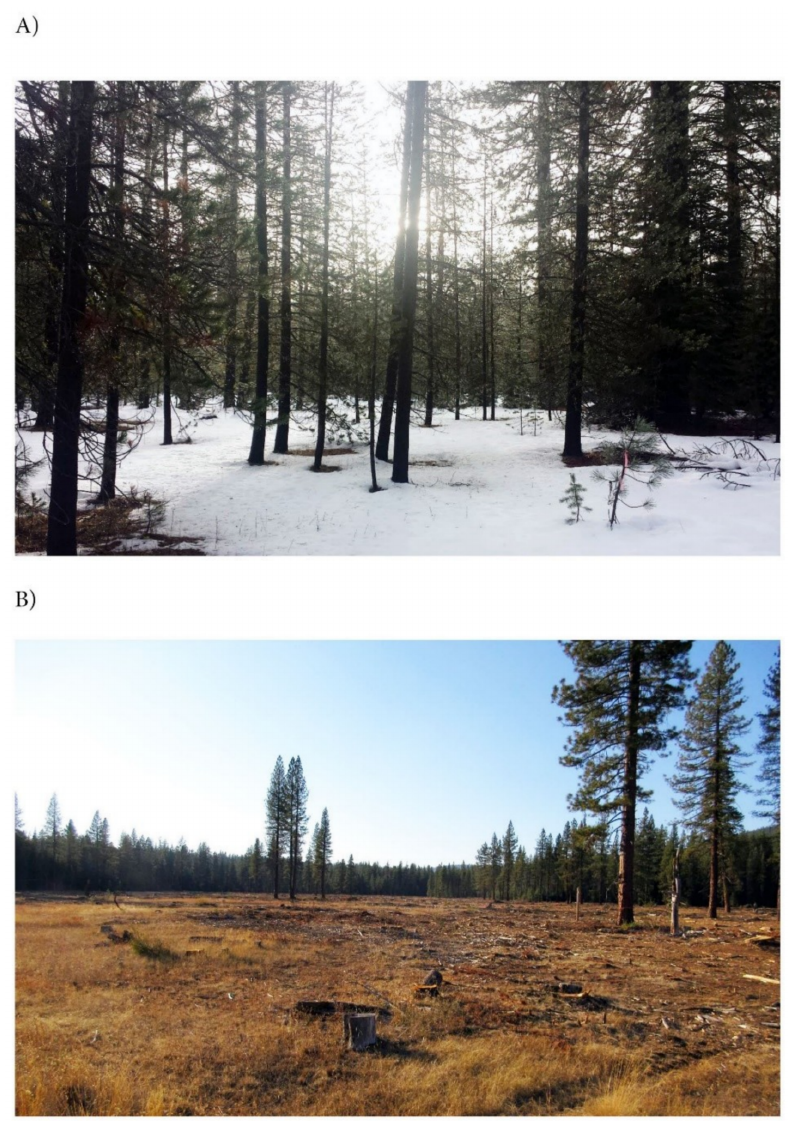
Figure 3. Marian Meadow before and after restoration to remove encroached lodgepole pine; view is looking north from California Route 36. ( A ) Marian Meadow with encroached conifers; December 2014. ( B ) Marian Meadow after restoration; September